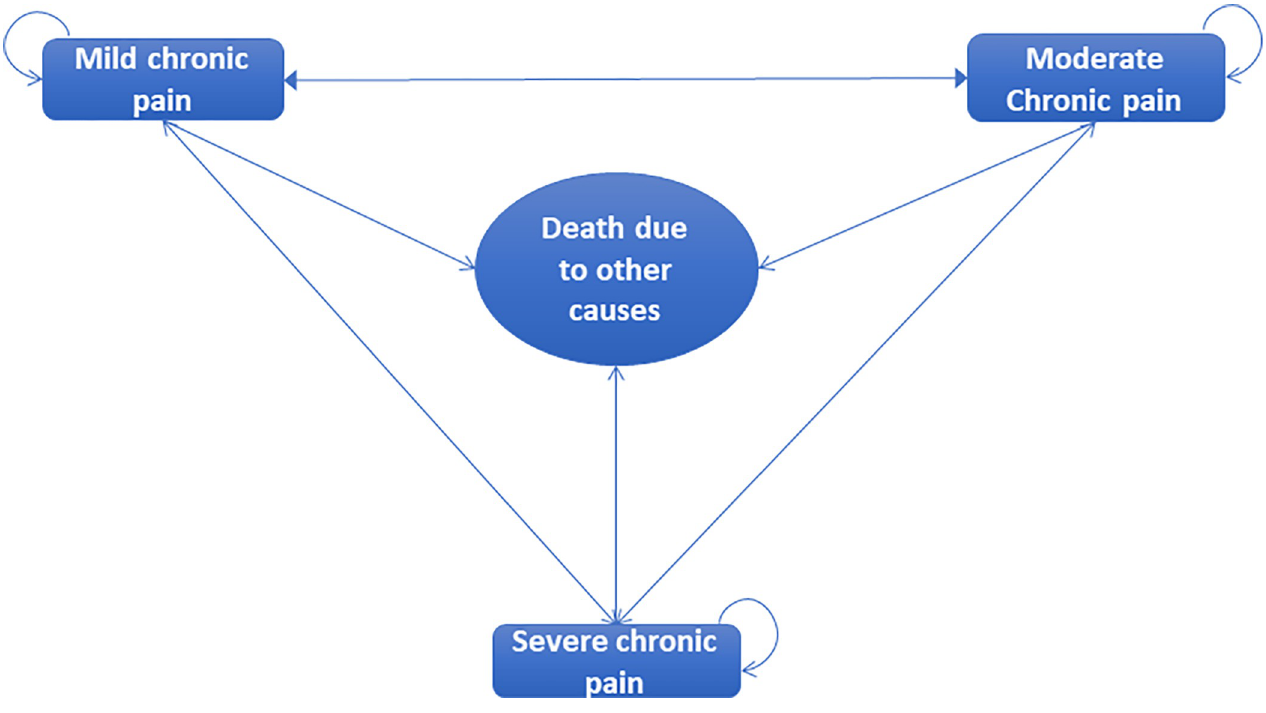
Fig 1. Cohort Markov model